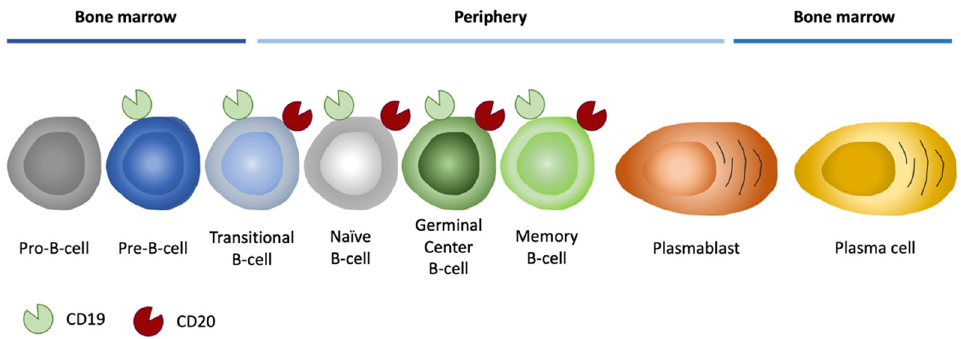
Figure 8. Expression of CD19 and CD20 in B-cell lineage. Illustrative representation of B-cell differentiation and maturation. CD19 antigen is expressed from pro-B-cells to plasma cells, hence CD20 from pre-B-cells to plasma cells.